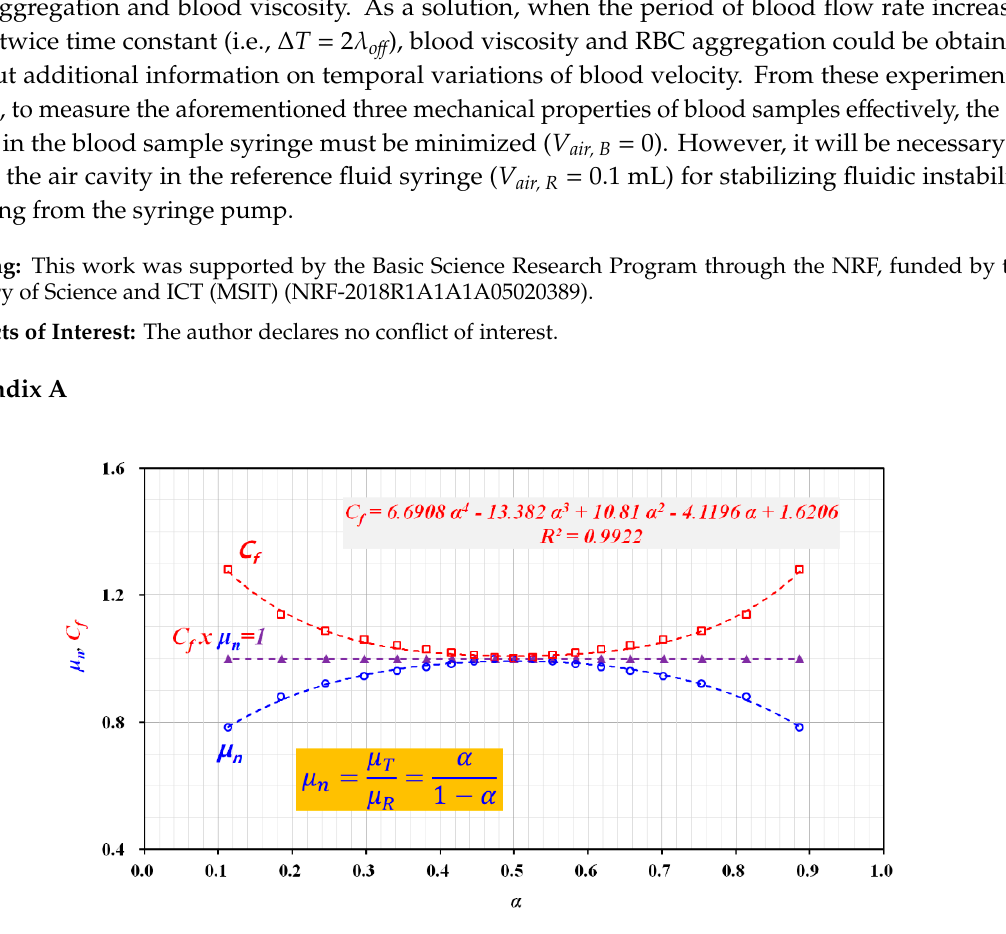
Figure A1. Variations of normalized viscosity ( μ n ) with respect to interface ( α ) in coflowing channel. Based on the principle of parallel streams [47], μ n was expressed as μ n = μ T / μ R = α /(1 − α ). μ T and μ R represent viscosity of test fluid and reference fluid, respectively. As the viscosity of test fluid is assumed as constant with respect to α , correction factor ( C f ) was then obtained as C f = 6.6908 α 4 – 13.382 α 3 + 10.81 α 2 – 4.1196 α + 1.6206 ( R 2 = 0.9922) by using the following relationship (i.e., C f x µ n = 1).